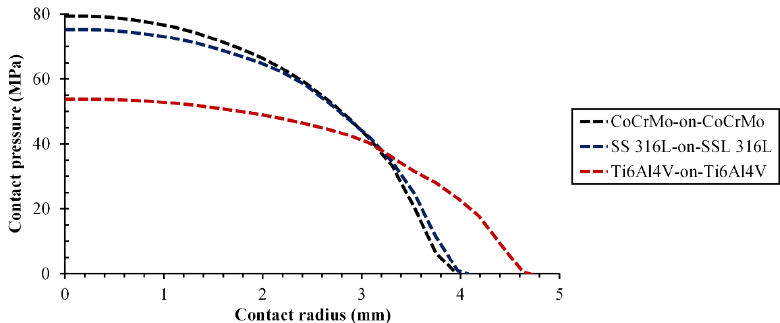
Figure 8. Correlation between contact pressure and contact radius at 7th phase.